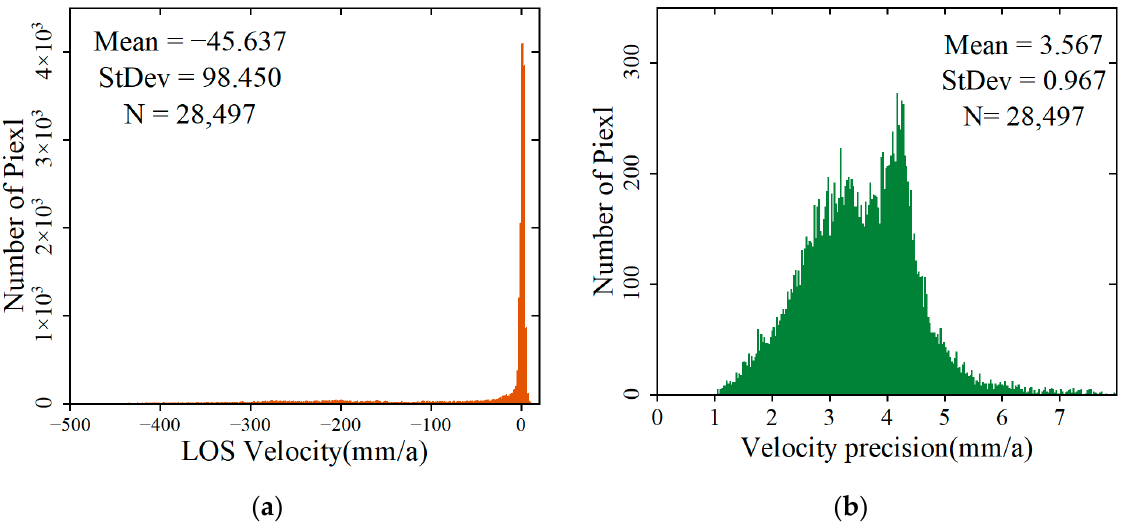
Figure 5. ( a ) Histogram of deformation rate vs. number of pixels; ( b ) histogram of deformation rate precision vs. number of pixels.